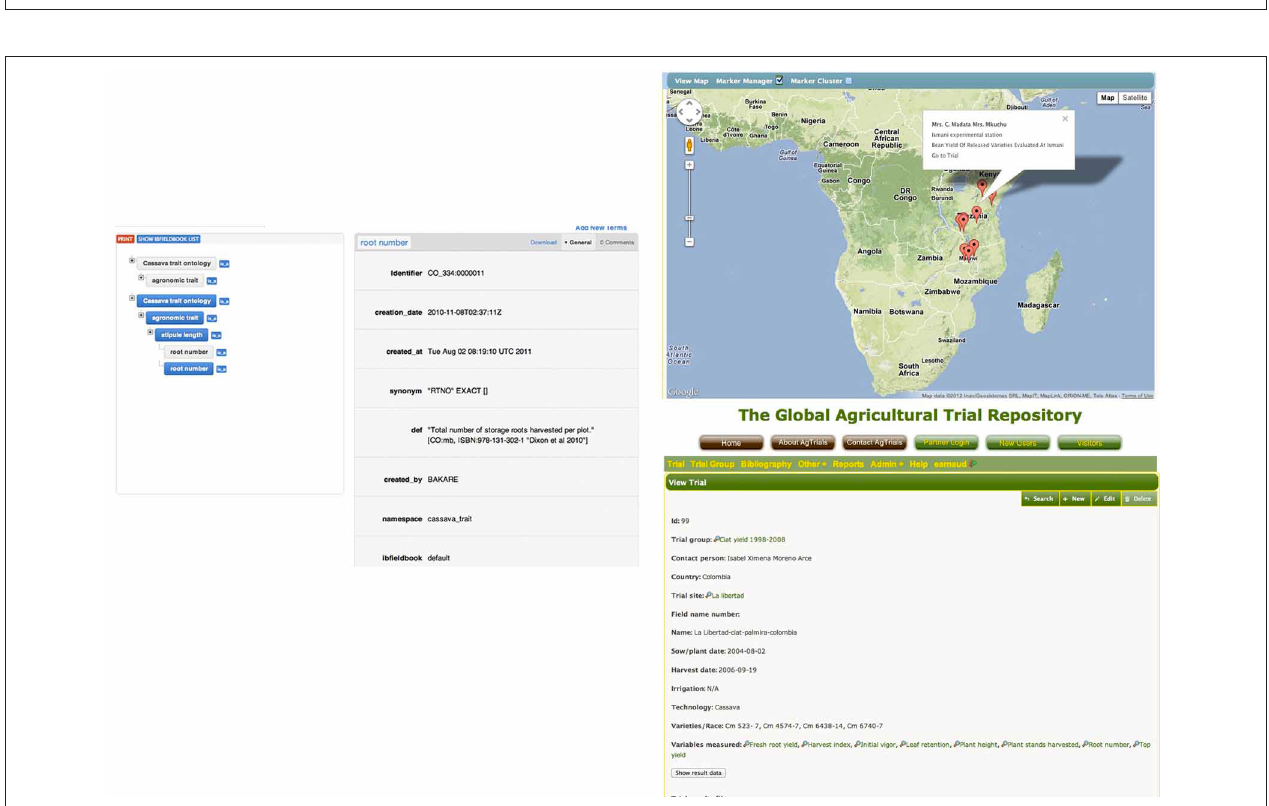
FIGURE 9 | Screenshot showing the dynamic link from the variable “spikelet fertility” on Agtrials to additional information in the online Rice Ontology.